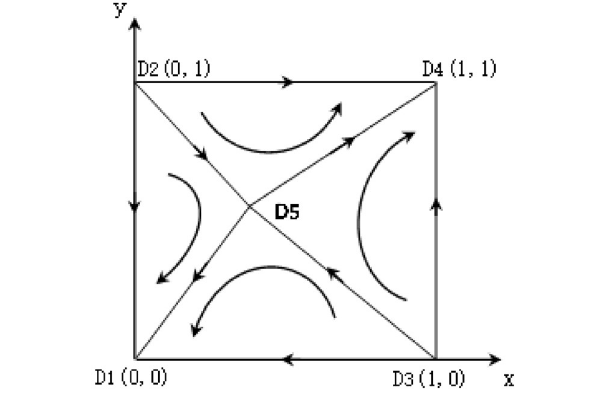
FIGURE 1 | Dynamic process of the game between urban hospitals and community health service institutions.